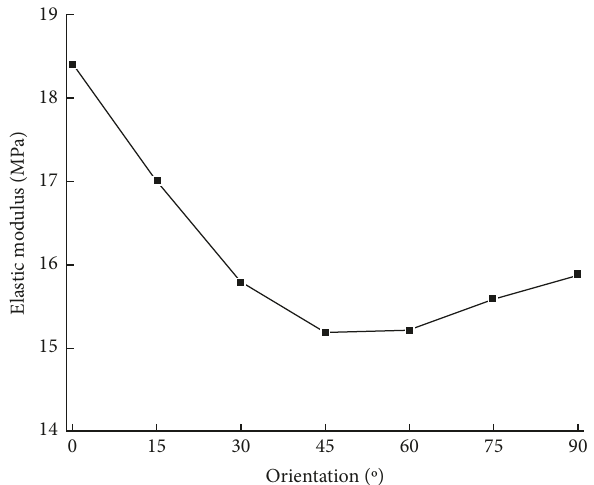
Figure 15: Macroelastic modulus obtained by numerical